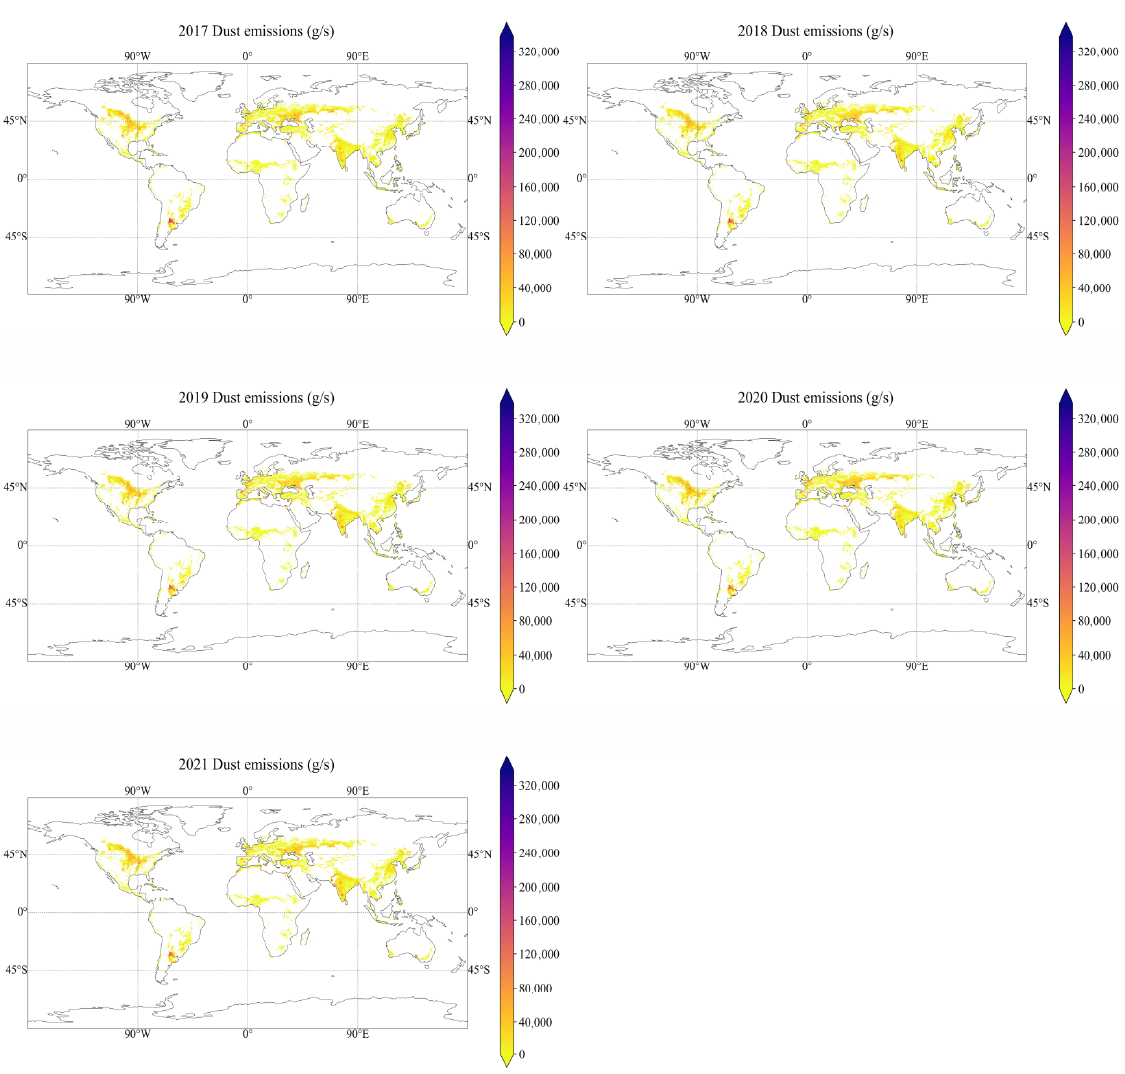
Figure 1. Spatial distribution of global dust emissions from agricultural lands in 2017–2021. The annual global dust emissions from agricultural land for each year from 2017 to 2021 are 1.65 × 10 9 g/s, 1.69 × 10 9 g/s, 1.71 × 10 9 g/s, 1.83 × 10 9 g/s, and 1.89 × 10 9 g/s,